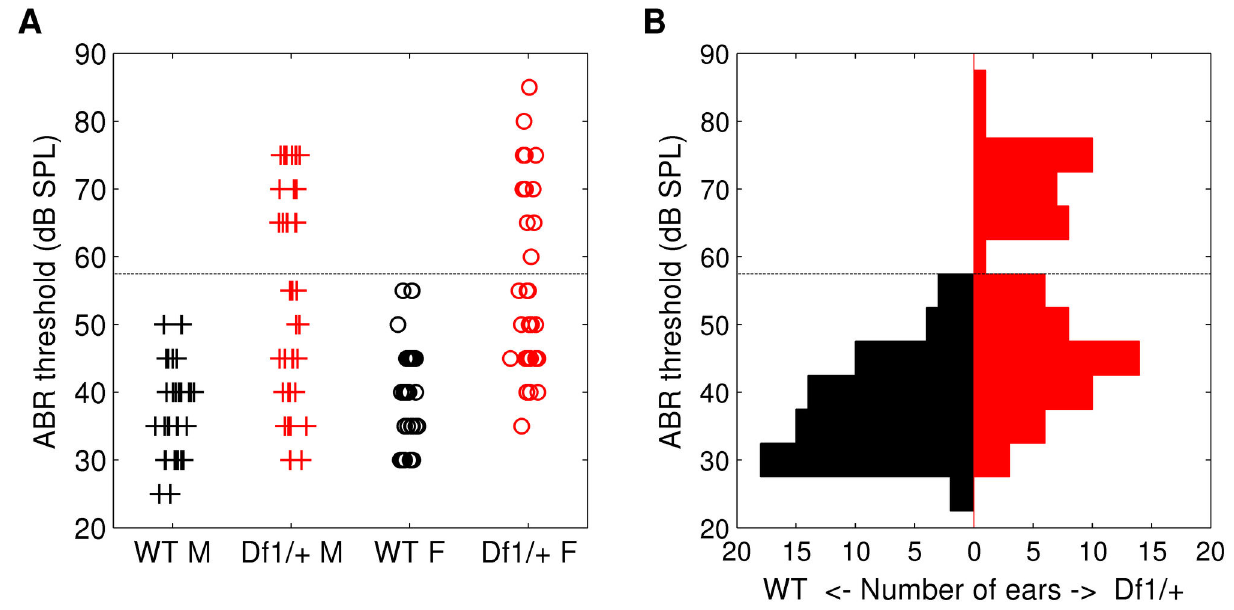
Figure 1. Elevated ABR thresholds, and bimodal distribution of thresholds, in Df1/+ mice. (A) Click ABR thresholds recorded from individual ears in male and female WT (black) and Df1/+ (red) mice. Median ABR thresholds differed significantly between Df1/+ and WT mice of the same gender (Wilcoxon Mann-Whitney test, Df1/+ versus WT: p=6x10 -6 males, p=9x10 -7 females), but not between males and females of the same genotype (Wilcoxon Mann-Whitney test, males versus females: p=0.3 Df1/+ , p=0.5 WT). (B) Click ABR thresholds pooled across recordings from male and female animals, to illustrate the bimodal appearance of the Df1/+ ABR threshold distribution. Dashed lines indicate the criterion threshold for a significant click ABR deficit (see text). doi: